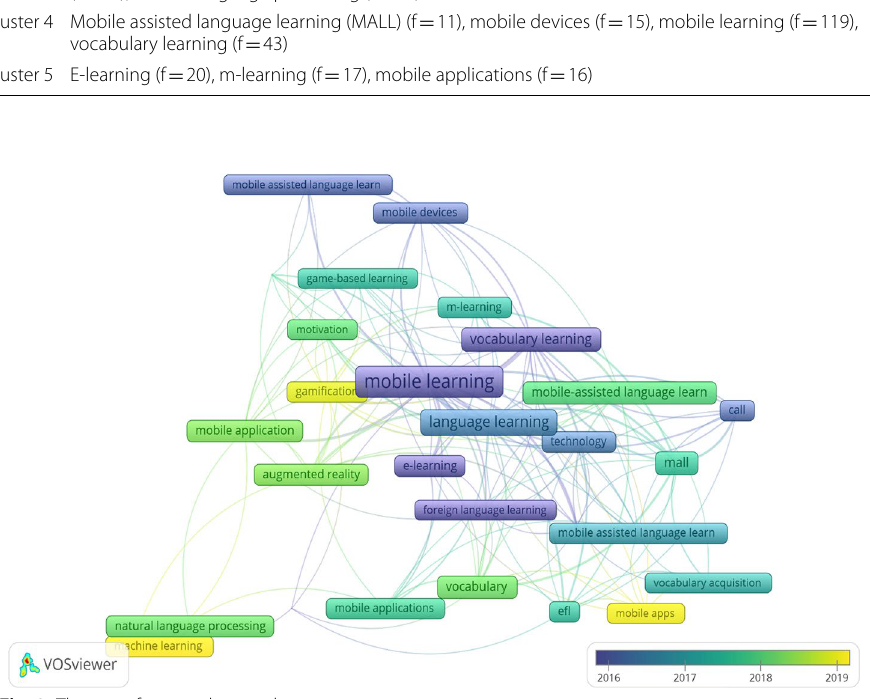
Table 3 The most frequent key-words Clusters Items Cluster 1 CALL (f 15), computer-assisted language learning (f 13), EFL (f 16), foreign language learning = = = (f 11), MALL (f 35), mobile apps (f 10), mobile-assisted language learning (f 32), mobile assisted = = = = language learning (f 15), technology (f 17), vocabulary (f 30), vocabulary acquisition (f 10) = = = = Cluster 2 Augmented reality (f 10), English learning (f 10), game-based learning (f 14), gamification = = = (f 16), language learning (f 57), motivation (f 12) = = = Cluster 3 Deep learning (f 14), machine learning (f 17), mobile application (f 20), mobile technology = = = (f 14), natural language processing (f 20) = =